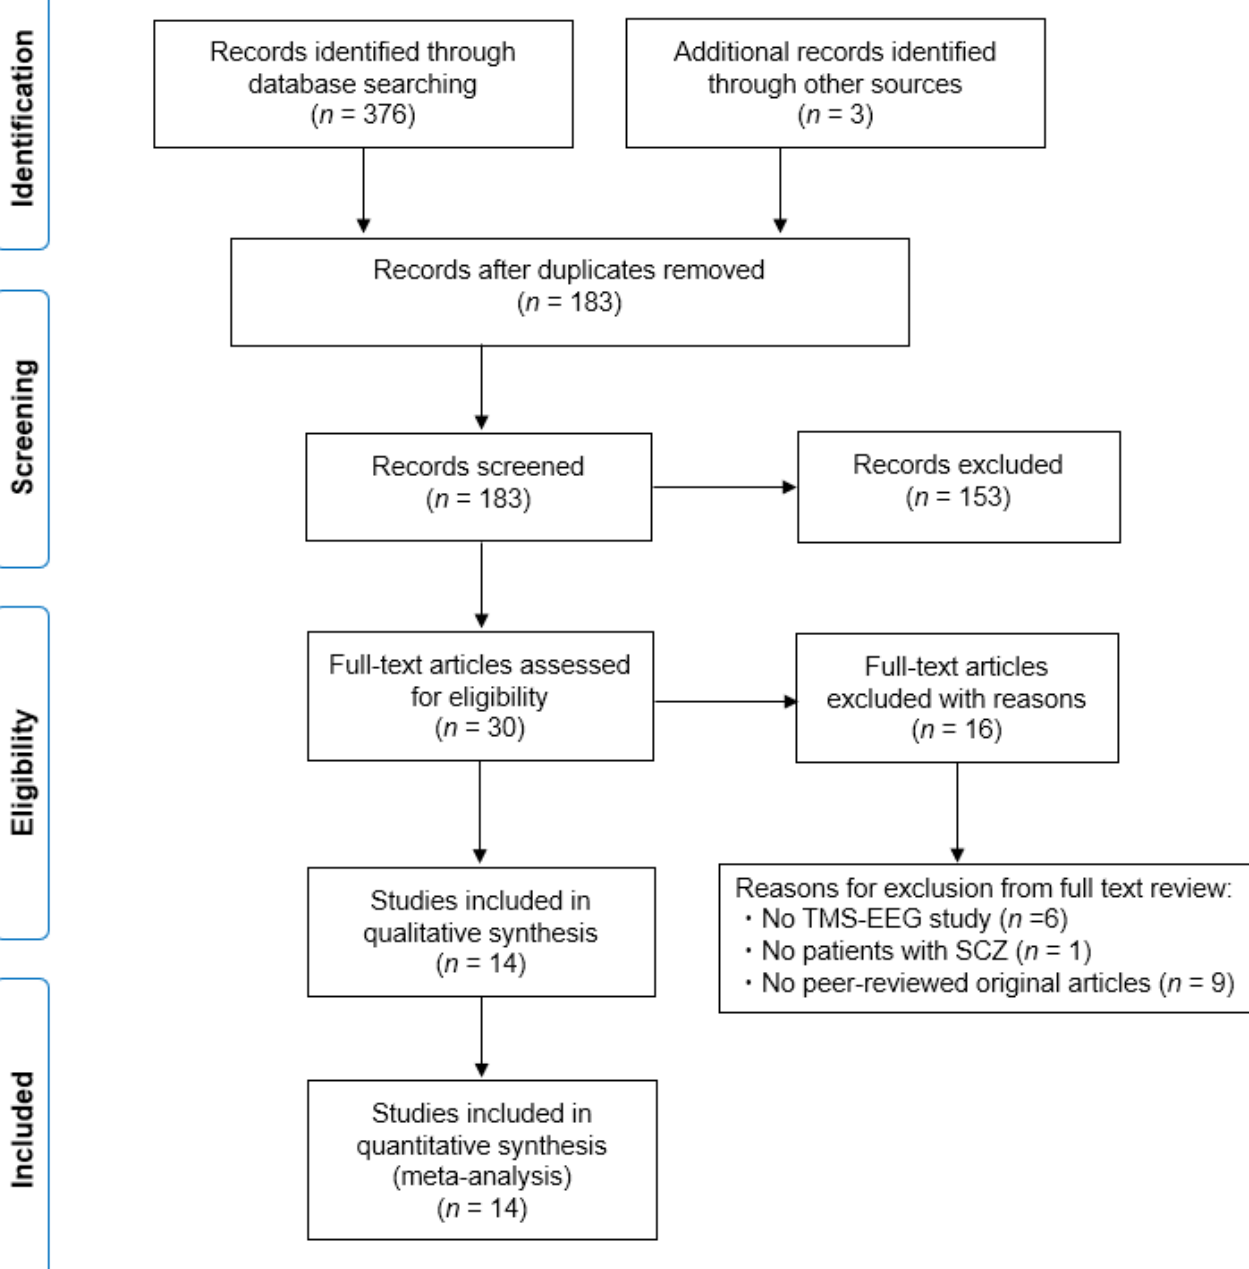
Figure 1. The PRISMA flow diagram.